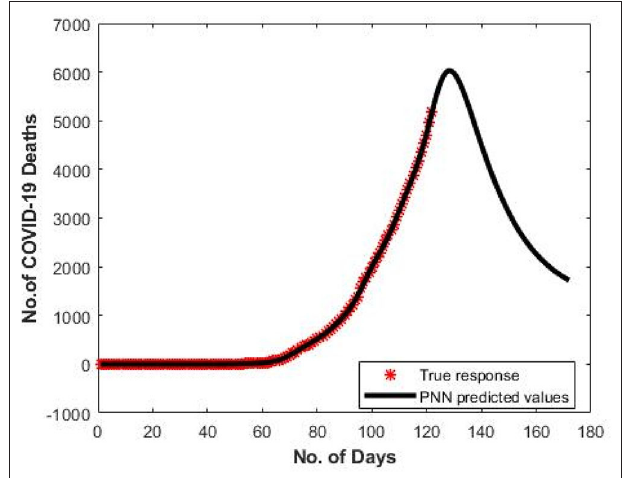
FIGURE 6 | Predicted curve for D1 using PNN.